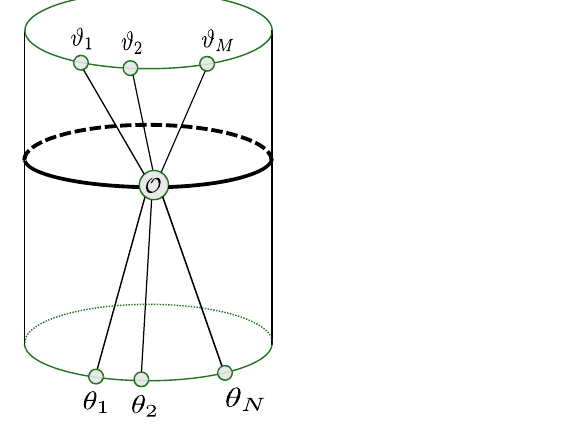
Figure 14 . Graphical representation of the form factor F -term L¨uscher correction. A virtual particle pair appears from the vacuum and after travelling around the world is absorbed by the